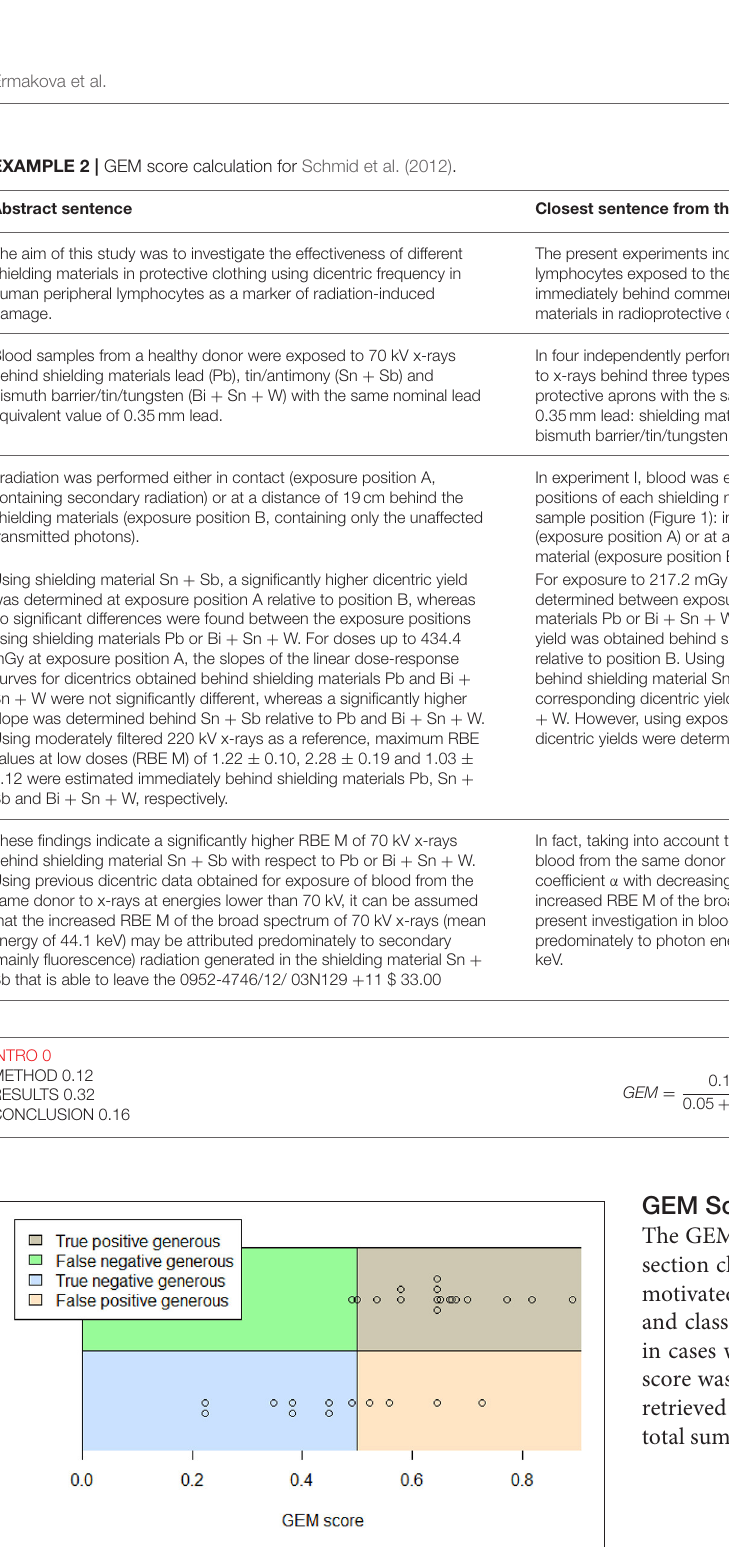
FIGURE 4 | GEM scores according to ground